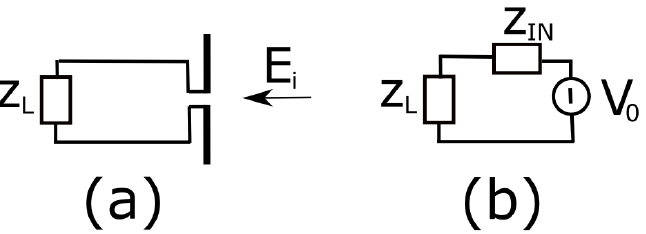
Figure 2. Circuit with antenna in receive mode; ( a ) schematic diagram; ( b ) circuit diagram Even if the re-irradiated energy is quite small, it can be received by antennas that are very close to the re-irradiating antenna, causing mutual coupling. The analysis of mutual coupling for receiving antennas is quite complex. In the following, we will introduce a simplified model that allows us to have a rough idea of the impact of the mutual coupling.